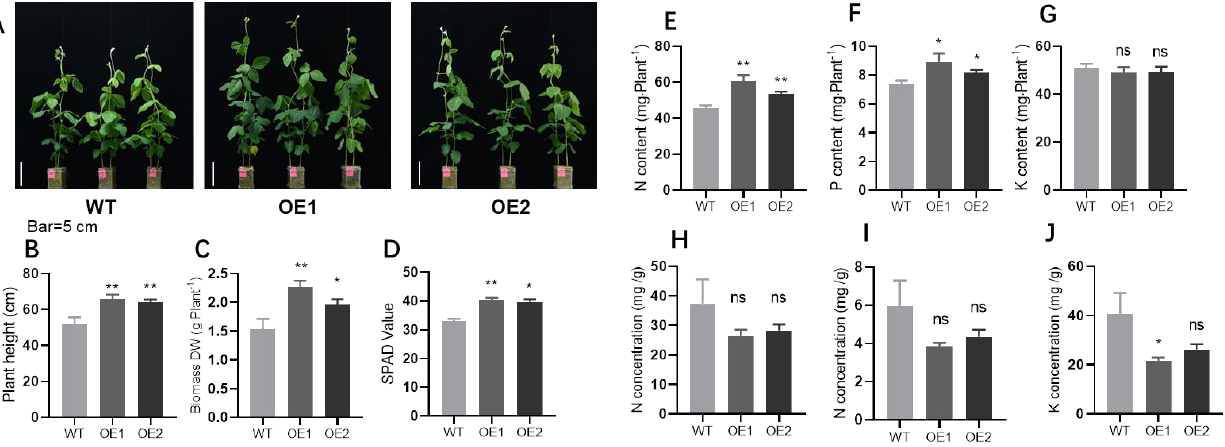
Figure 2. Overexpression of GmPHR1 promotes soybean growth. ( A ). Growth performance of wild type and transgenic soybean seedling lines overexpressing GmPHR1 (OE1 and OE2). Bar = 5 cm. ( B – D ). Plant height ( B ), biomass (DW: dry weight) ( C ), and leaf SPAD values ( D ) were measured after one-month of growth. n = 10. ( E – G ). Total nitrogen ( E ), phosphorus ( F ), and potassium ( G ) contents of soybean plants in ( F ). ( H – J ). Total nitrogen ( H ), phosphorus ( I ), and potassium ( J ) concentrations of soybean plants in ( F ). For ( B – J ), asterisks represent statistically significantly differences from respective controls in the Student’s t test (*: 0.01 < p ≤ 0.05, **: 0.001 < p ≤ 0.01). ns: not significant at 0.05